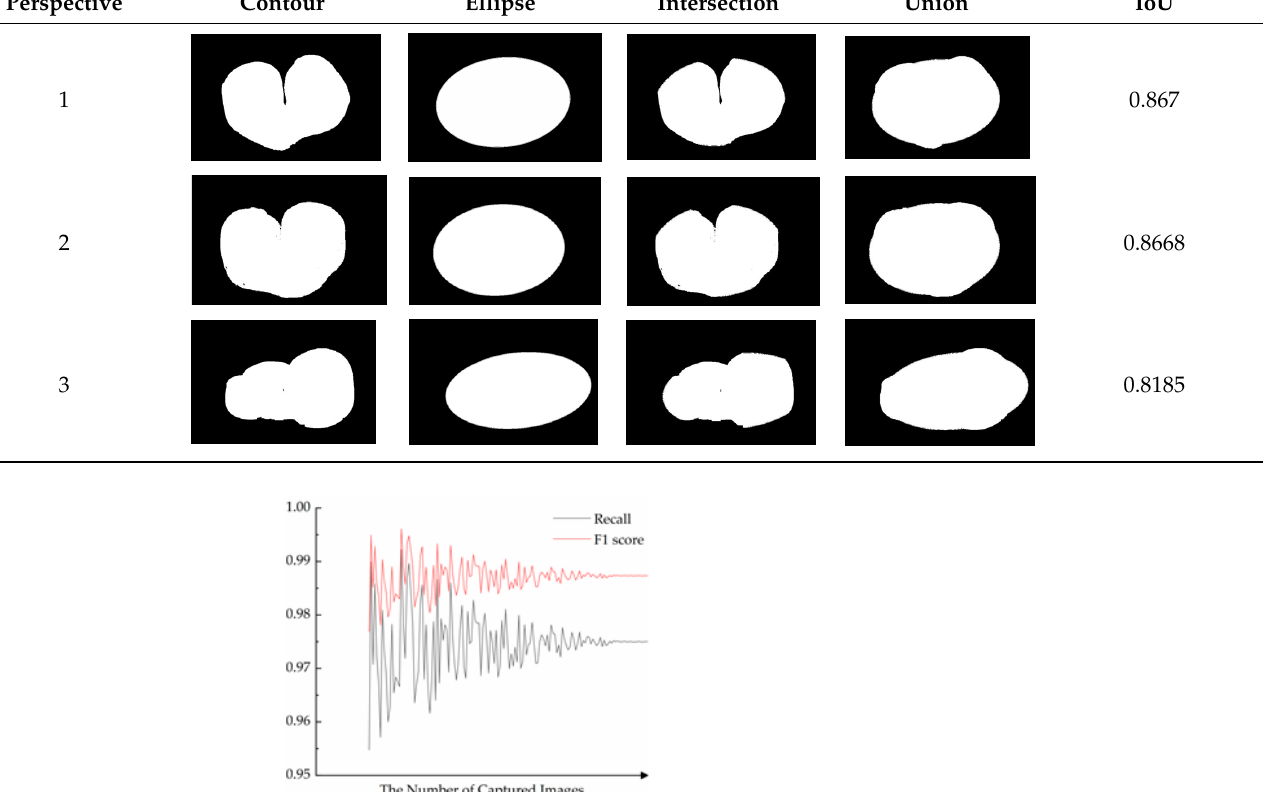
Table 9. IoU calculation results for irregular potatoes with multiple views. Perspec-